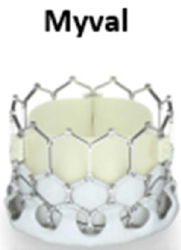
Figure 5. The Myval balloon-expandable valve is made by a nickel-cobalt alloy frame which is created of a single design element open cell hexagons while the remainder has closed cells with higher annular radial force towards the ventricular end.